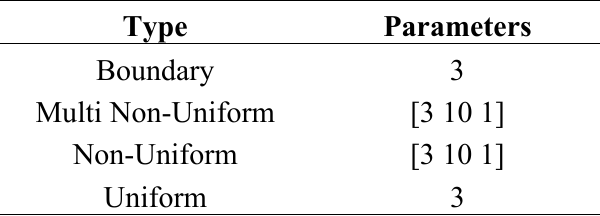
Table 5. Mutations